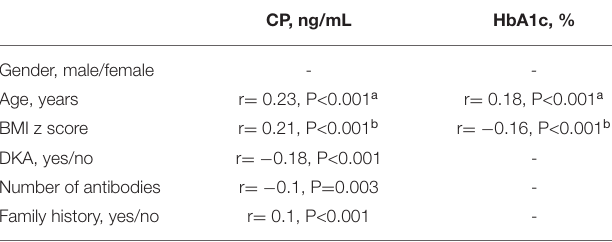
TABLE 1 | Relationships between the clinical parameters of participants.